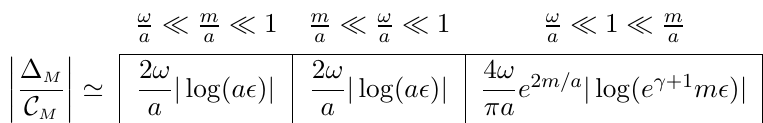
Table 7 . The leading-order behaviour for the function (cid:1) (cid:1) = C (cid:28) 1. The third column with a e 2 m=a factor may seem alarming (i.e. possibly not small), M M but in fact the last row in table 6 ensures that the combination ! (cid:0) (cid:1) where contributions O (cid:1) 2 = C 2 have been neglected. At late times g 2 a(cid:28) (cid:24) O (1) M M